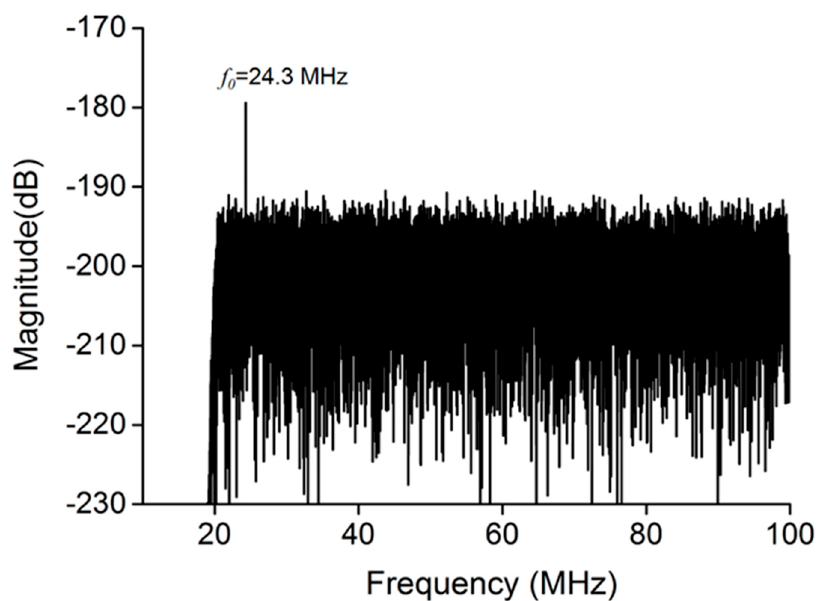
Figure 4. The measurement of bubble cavitation in the PDMS channel. No harmonic signal or broadband noise was observed, indicating that no bubble cavitation had occurred.